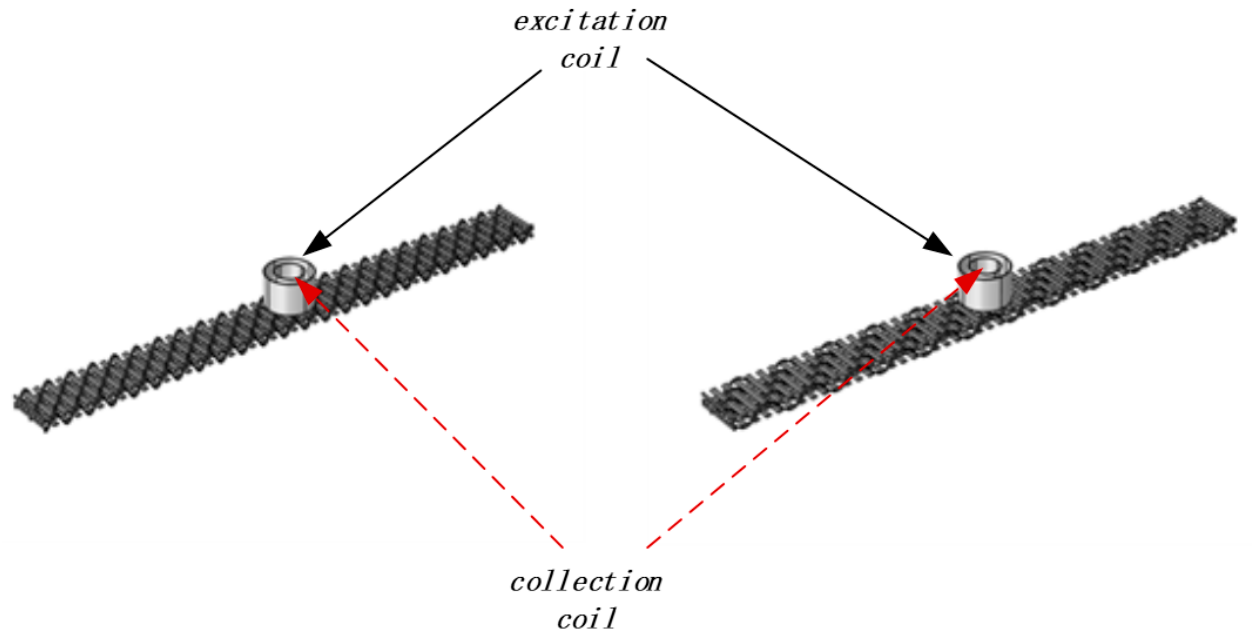
Figure 6. Electromagnetic coil detection model, the large coil is the excitation coil and the small coil is the collection coil. The lift ‐ off height of the dual ‐ coil sensor is 0.3 mm from the sample surface, and the